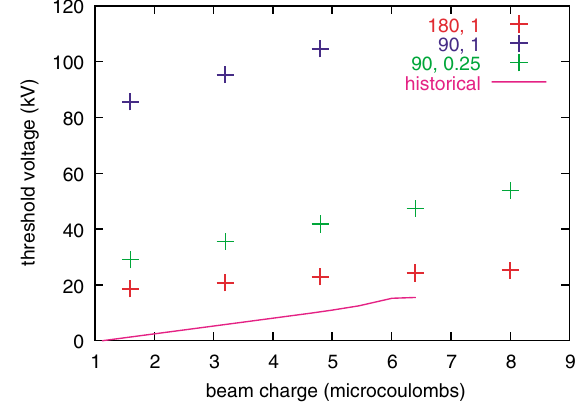
FIG. 19. (Color) PSR threshold voltage versus bunch charge for rms bunch lengths of 180 and 90 ns and electron line densities of 1 and 0 : 25 nC = m , with an rms emittance of 8 : 5 mm mrad . The symbols are for maximal space-charge tune spread with q=E (cid:5) 3 = 5 and the solid line is the historical PSR data.